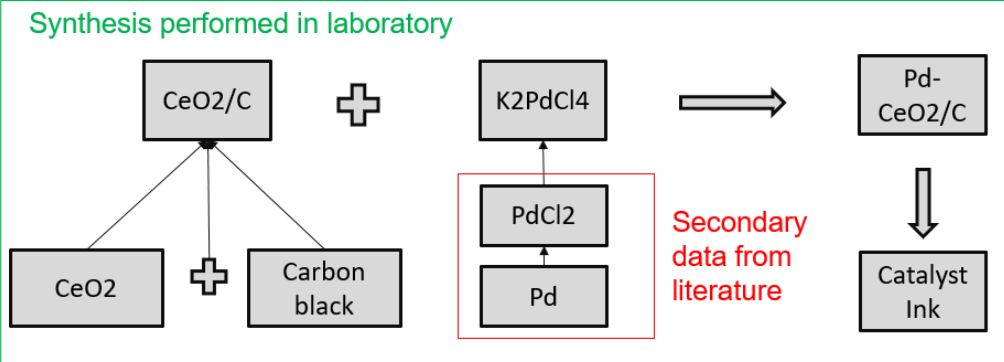
Figure 3. Synthesis of Pd@CeO 2 /C: the syntheses contained in the green box have been performed in Sesto Fiorentino, the syntheses in the red box had to be inserted in SimaPRO, in order to obtain K 2 PdCl 4 which was not present in the database.